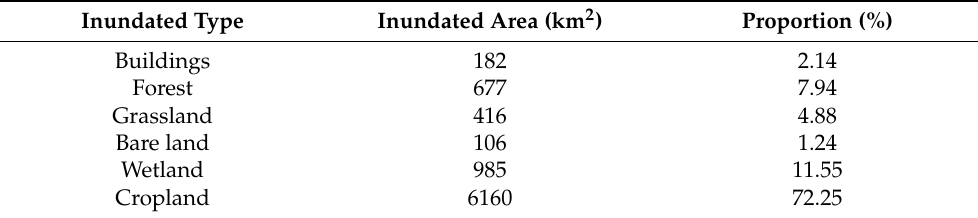
Table 6. The statistics of inundated land by land use in the MLB. Inundated Type Inundated Area (km 2 )